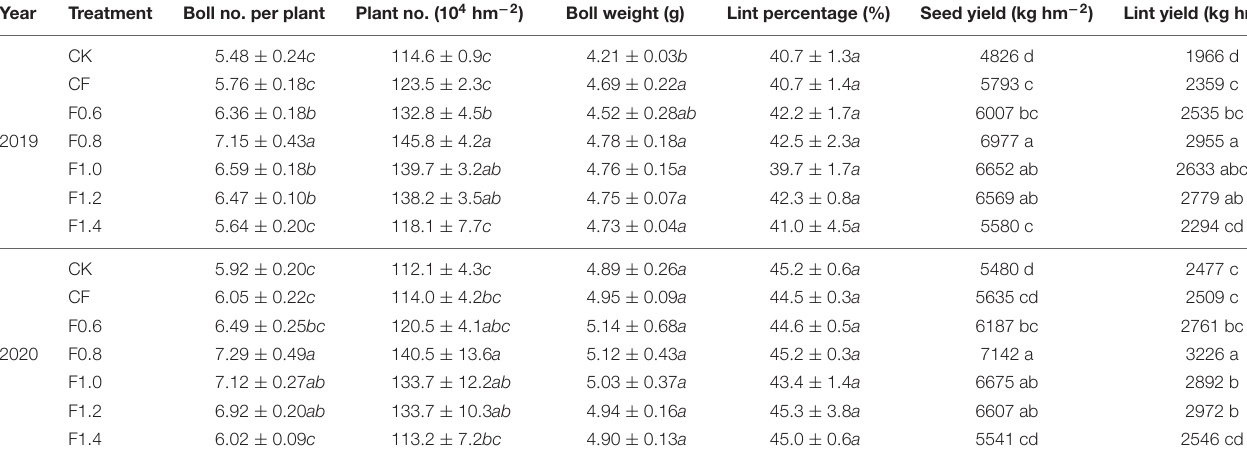
TABLE 4 | Cotton yield and its components under different fertilization